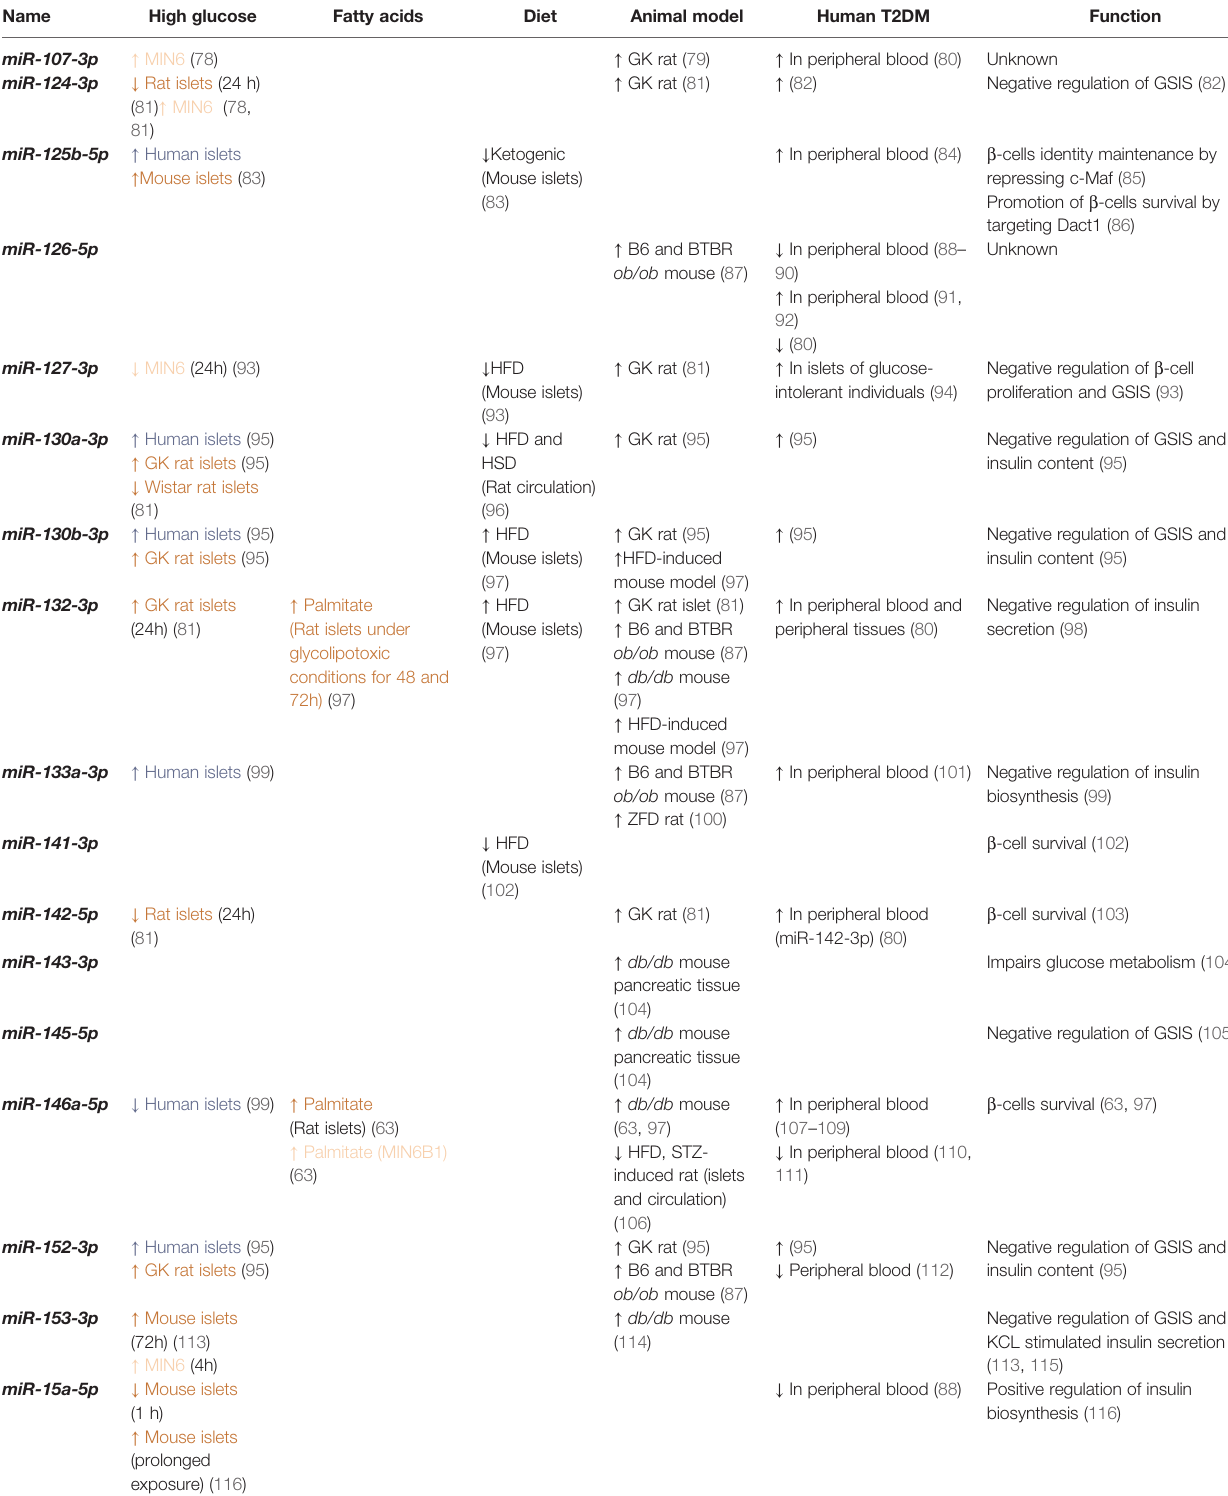
TABLE 1 | Glucose/lipid regulated islet